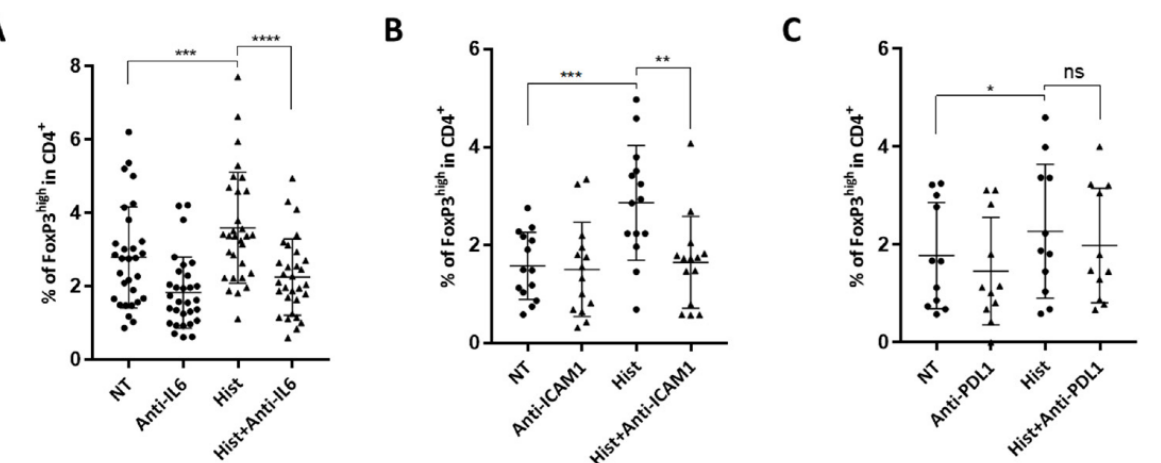
Figure 4. IL-6 and ICAM-1 are implicated in the mechanisms of Treg expansion in this model of endothelial cell activation by histones. ( A ) HMECs pre-treated with histones for 18 h were washed